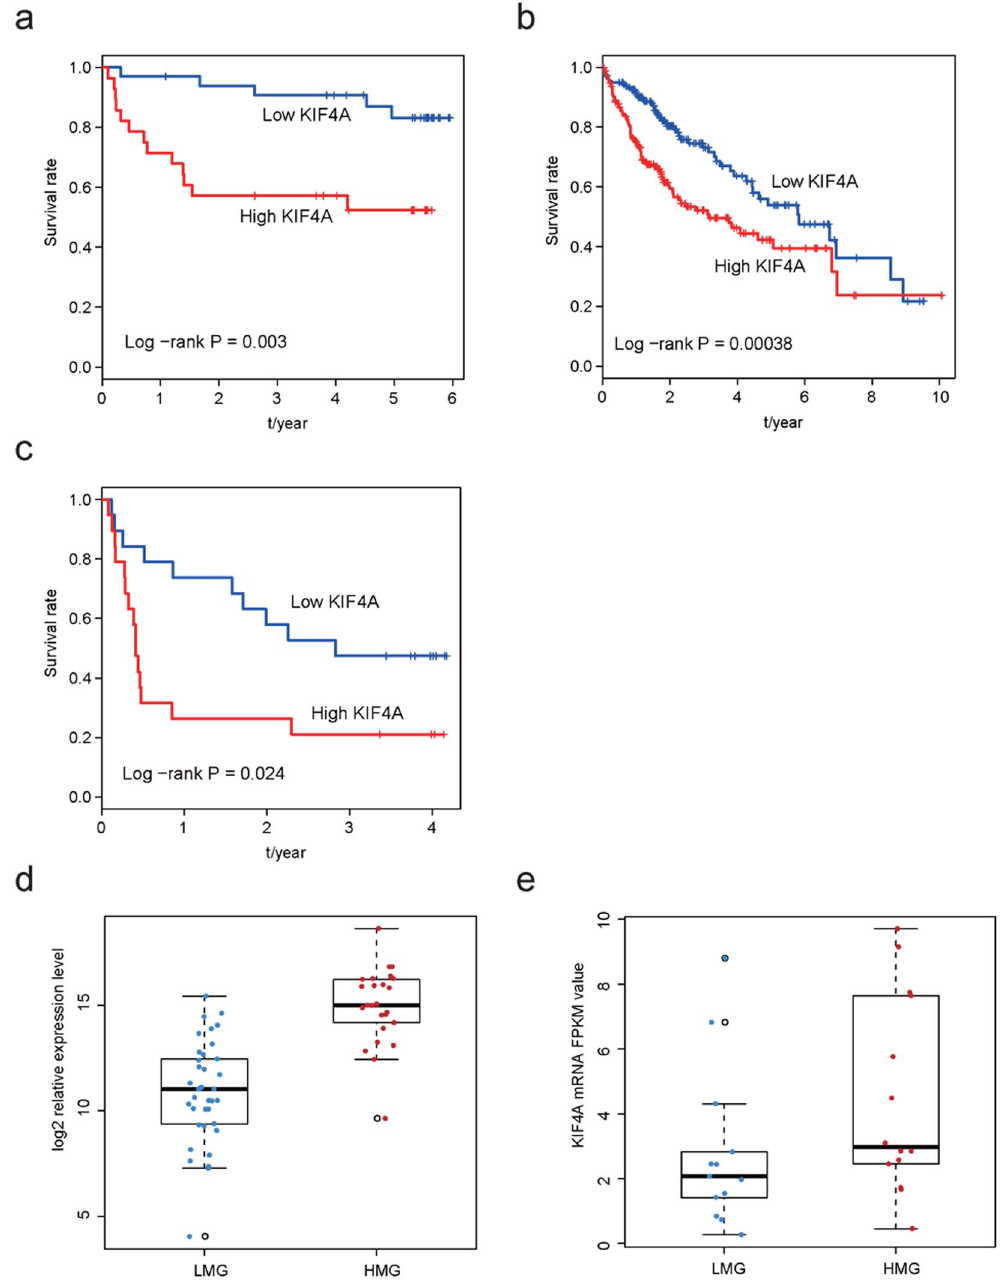
Figure 2. The prognostic effect of KIF4A in HCC. Patients with high KIF4A expression has a relatively poor overall survival rate according result from RT-PCR ( a ), TCGA ( b ) and GSE77314 ( c ); the mRNA expression level of high metastasis patients is significantly higher compared with low metastasis patients in our RT-PCR cohort ( d ) and GSE77314 cohort ( e ). FPKM: Fragments Per Kilobase of transcript per Million mapped